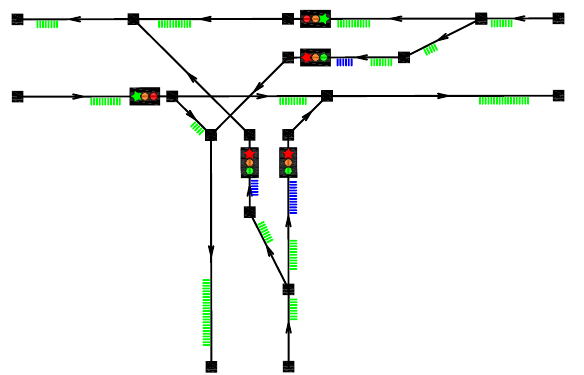
Figure 5. First example: T-shape